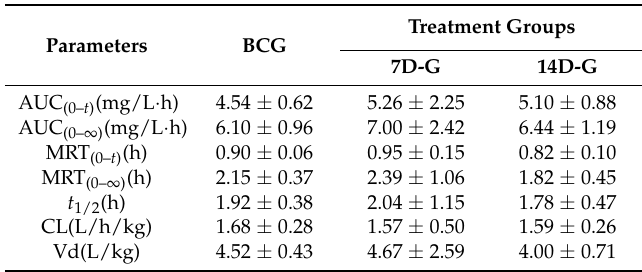
Table 3. Effects of SGI on pharmacokinetic parameter of omeprazole (2.0 mg/kg).